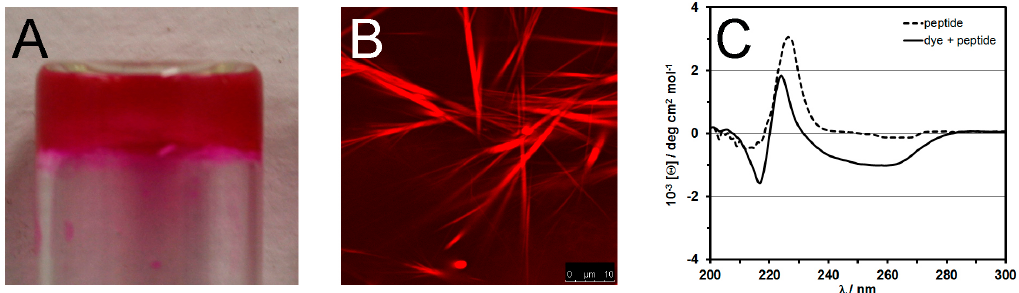
Figure 3. Rhodamine B actively participates in the assembly process of a tripeptide to yield a self-supportive hydrogel ( A ). Confocal fluorescence microscopy highlights the presence of the dye in the supramolecular structures ( B ); resulting in different circular dichroism spectra relative to the peptide alone ( C ) [68].